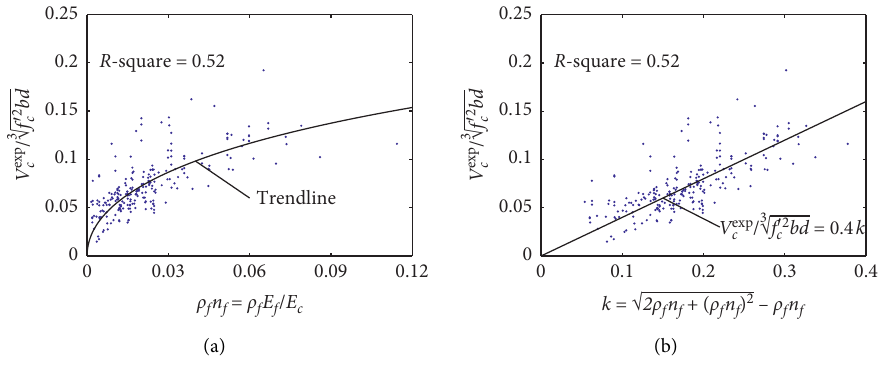
Figure 4: Effect of longitudinal reinforcement on ( V exp